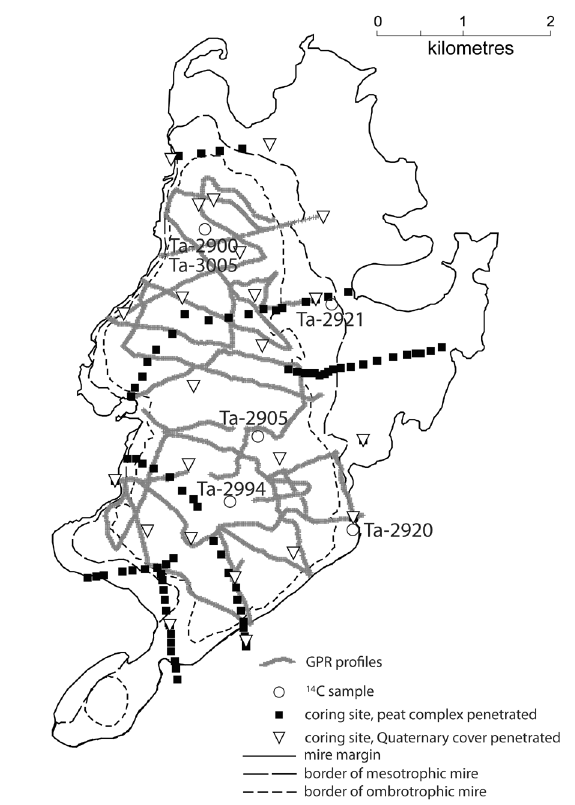
Fig. 2. Factual data obtained from the Selisoo mire, including GPR profiles, 14 C sampling and coring